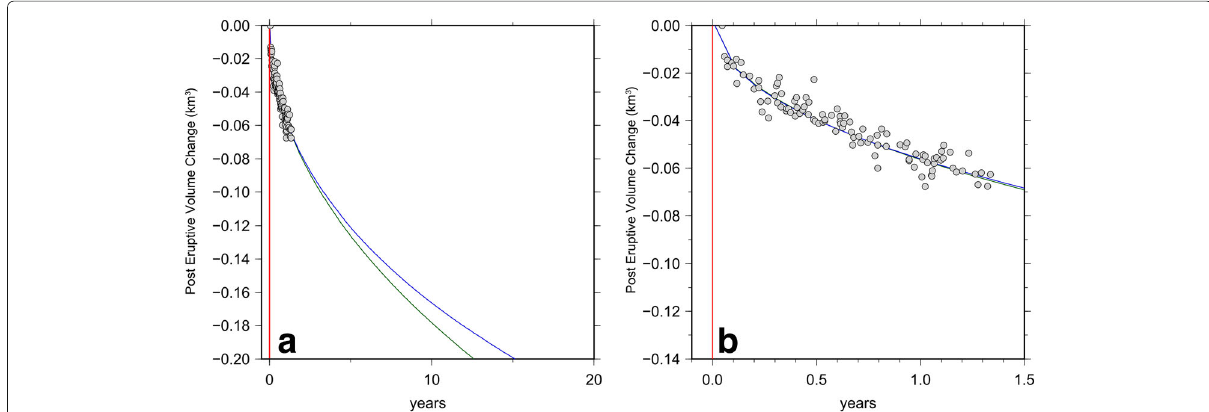
Fig. 8 The volume of thermal contraction calculated from the maximum value of (cid:8) is shown in blue, and the volume of contraction assuming a minimum is shown in green. Using (cid:8) min requires an initial starting radius of 0.944 km, and (cid:8) max results in an initial radius of 2.386 km. a Thermal model over a period of 20 years. b Model fit over the observation